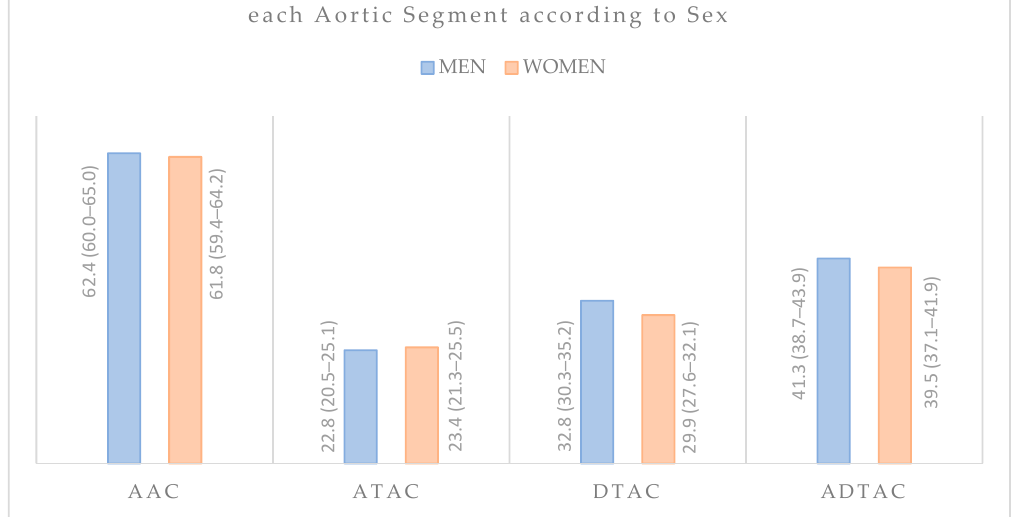
Figure 1. Venn diagram showing the distribution of calcium and the intersections of individuals according to aortic segments. The percentages refer to the total population ( n = 2427).